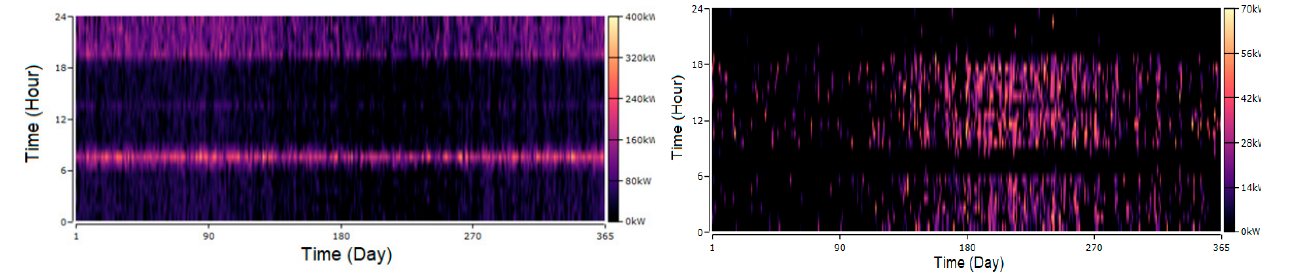
Figure 10. Kudat, RX-20KH3 wind turbine case.